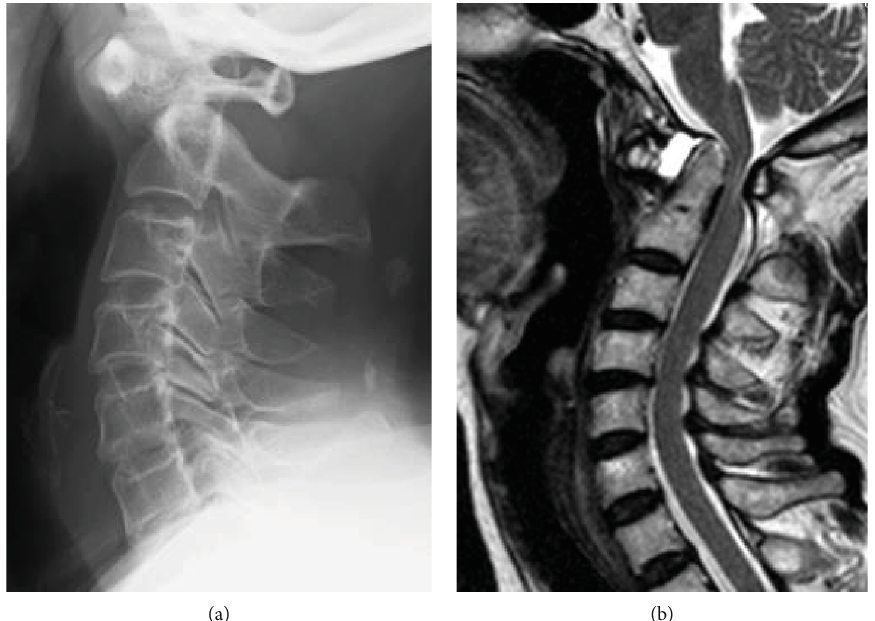
Figure 1: Side views of plain X-ray lateral standing images show atlantoaxial subluxation (a), and MRI con fi rms high compression of the spinal cord by the posterior arch of C1 (b).